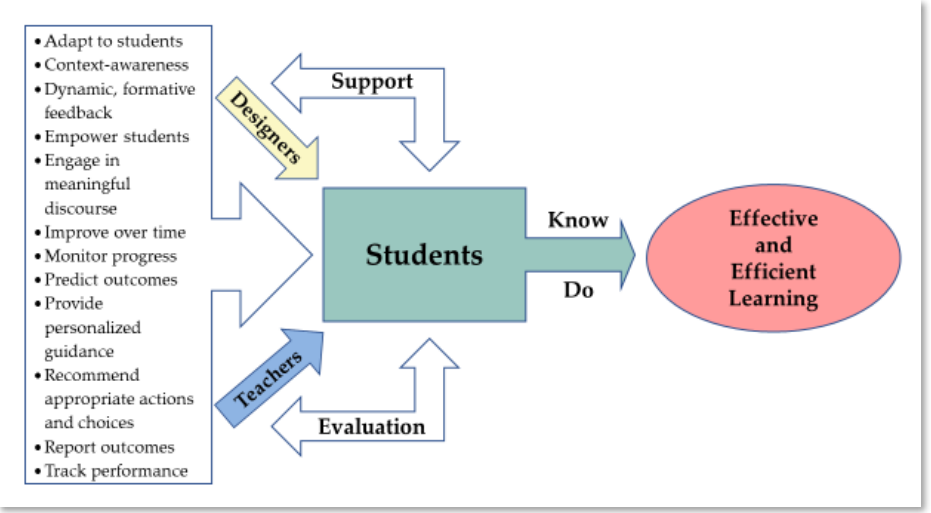
Figure 1. Smart technologies for learning and teaching ( source : adapted from Spector [23] (p. 28)).